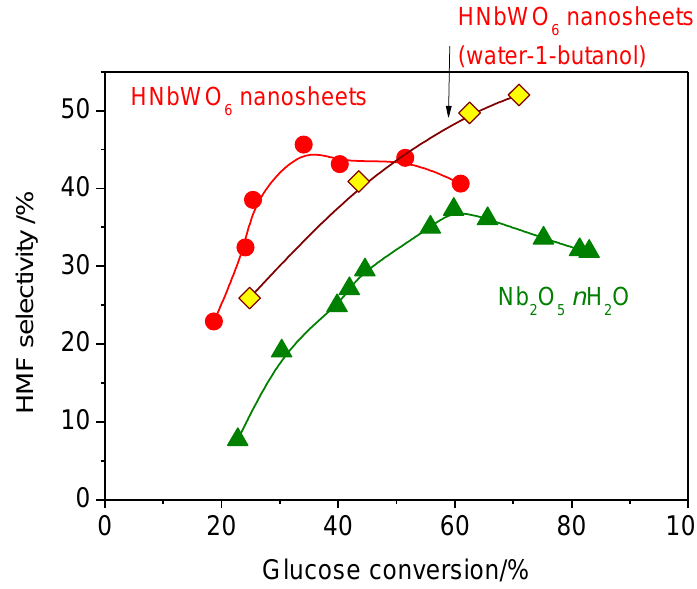
Figure 3. HMF selectivity vs. glucose conversion.